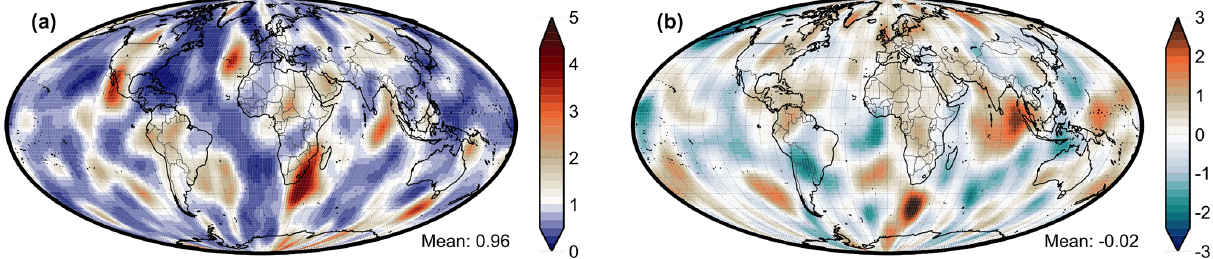
Figure 2. An example of the spatially correlated perturbations maps generated for an ensemble member regarding (a) dust emissions and (b) the U component of the